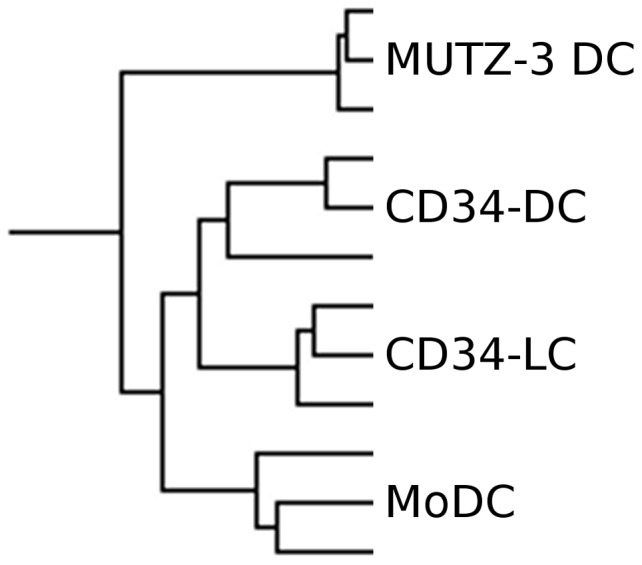
Hierarchical clustering of in vitro DCs.Clustering using complete linkage algorithm on differentially expressed transcripts (892), identified by ANOVA (p<10−6, corresponding to p<0,05 upon Bonferroni correction), demonstrates relationships among in vitro DC models.